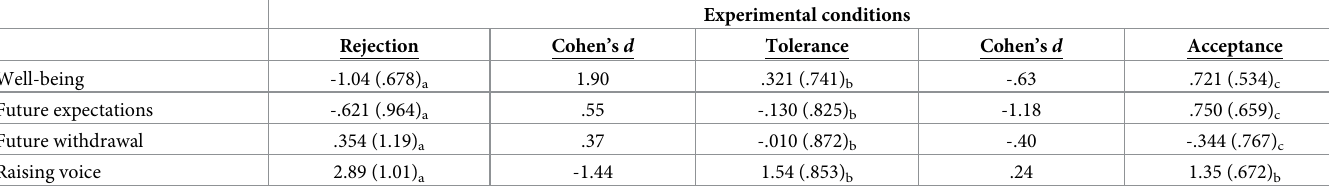
Table 5. Key outcome variable contrasts for Study 2.